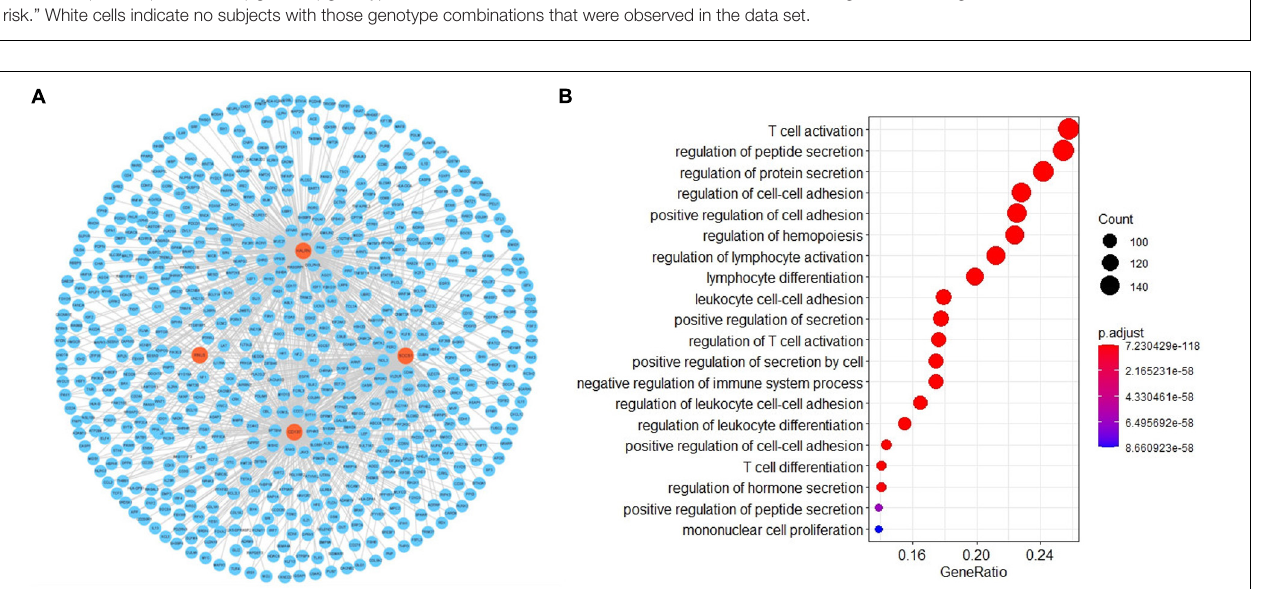
FIGURE 3 | The layout of mRNA-mRNA network. The view of the mRNA-mRNA network (A) . The GO enrichment analysis of the network (B) .